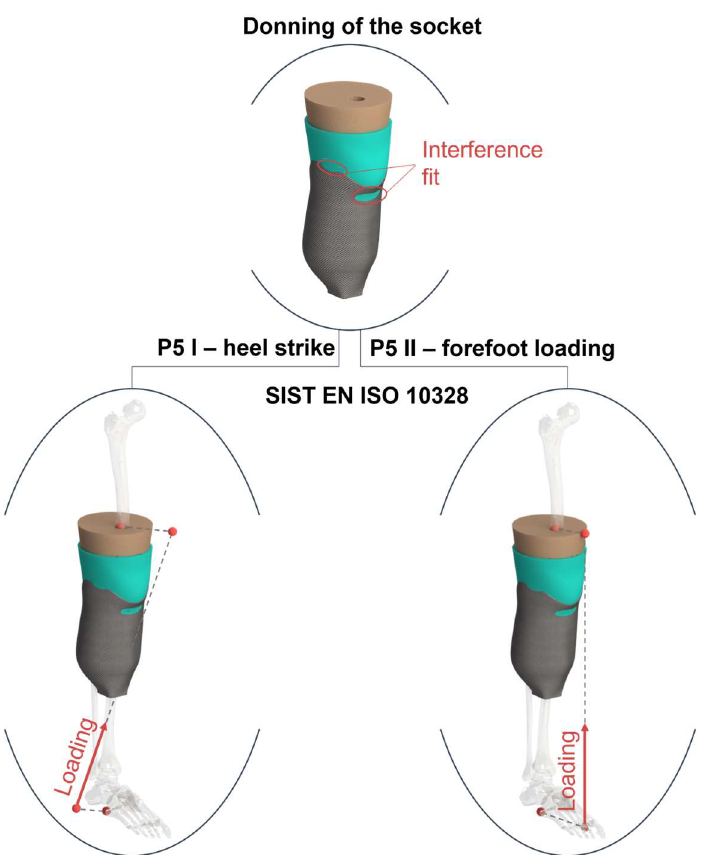
Figure 3. Load cases in the numerical simulation. Upper : Donning of the socket; the distal part of the socket and femoral cavity are fixed via remote points. Left : Heel strike loading case according to ISO 10328 P5 I. Right : Forefoot loading case according to ISO 10328 P5 II. Both Standard load cases were analyzed for the settling and proof test force. The red dots in the Figure represent remote points connected with rigid wires.